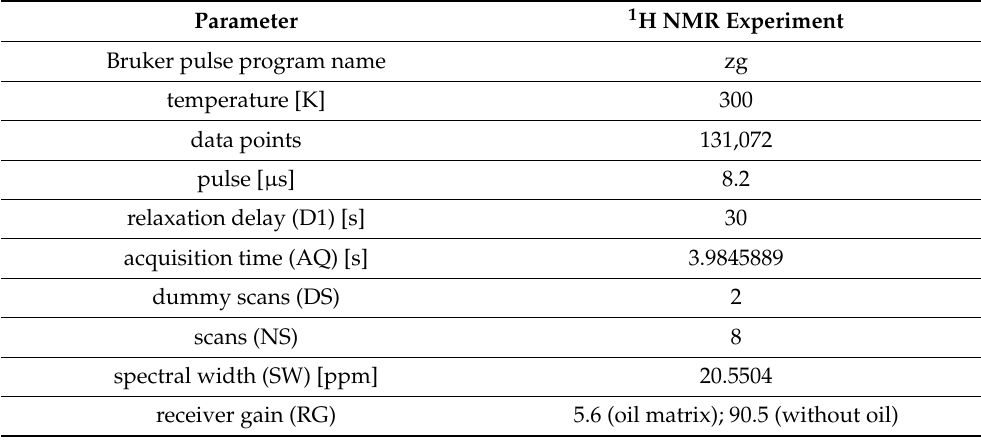
Table 1. Acquisition parameters of the initial NMR experiments for method development.